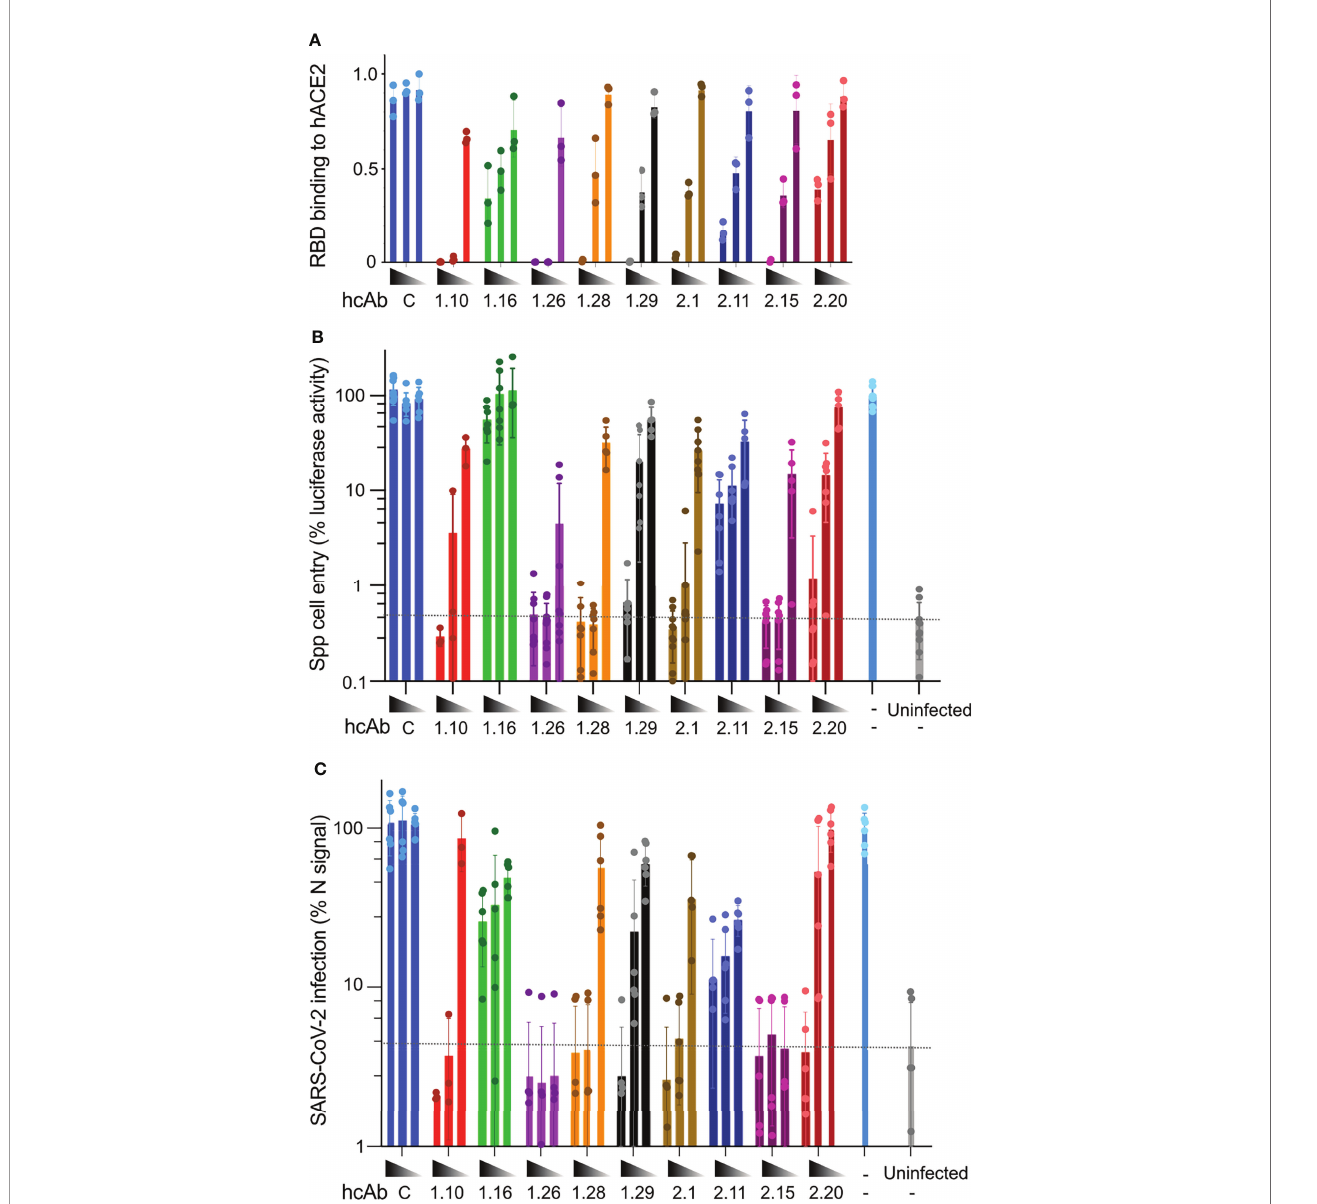
FIGURE 3 | hcAb inhibition of RBD binding to ACE2 and SARS-CoV-2 cell infection in vitro . (A) RBD binding to hACE2 in the presence of the indicated hcAbs (1.10, 1.16, 1.26, 1.28, 2.1, 2.11, 2.15, 2.20) or a control hcAb (C). Immunoassays with biotinylated RBD-Fc (20 nM) and increasing hcAb concentrations (50, 100 and 200 nM, from right to left). Mean and SD from three independent assays (n = 3). (B) Inhibition of Vero-E6 cell entry of pseudotyped viral particles with SARS- CoV-2 S protein (Spp) by the indicated hcAbs at increasing concentrations (0.5, 5 and 50 nM). The luciferase activity of cell cultures was determined 48 h.p.i. Background luciferase activity of uninfected cell cultures is shown with a dashed line. (C) Inhibition of SARS-CoV-2 virus cell infection by the indicated hcAbs as in (B) Infection ef fi ciency was determined by immuno fl uorescence 24 h.p.i. by staining with anti-N monoclonal Ab ( Materials and methods ). Background fl uorescence detected in uninfected cell cultures is shown with a dashed line. (B, C) Infected cell cultures without hcAb (-) used as positive controls for Spp and SARS-CoV-2